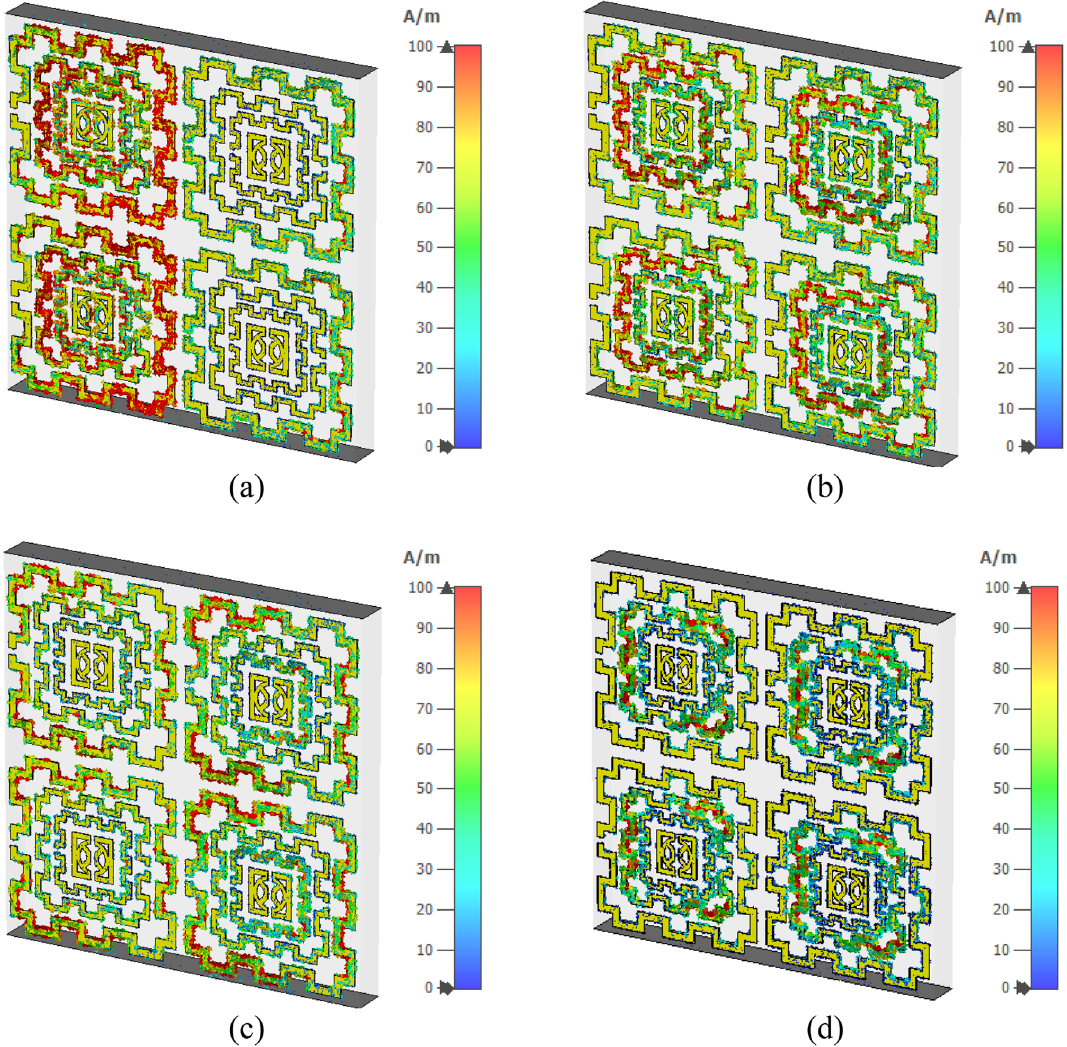
Figure 23. Surface current analysis of 2 × 2 array at ( a ) 2.63 GHz, ( b ) 4.28 GHz ( c ) 8.9 GHz, and 13.7 GHz. (CST STUDIO SUITE 2019, https:// www. 3ds. com/ produ cts- servi ces/ simul ia/ produ cts/ cst- studio- suite) 28